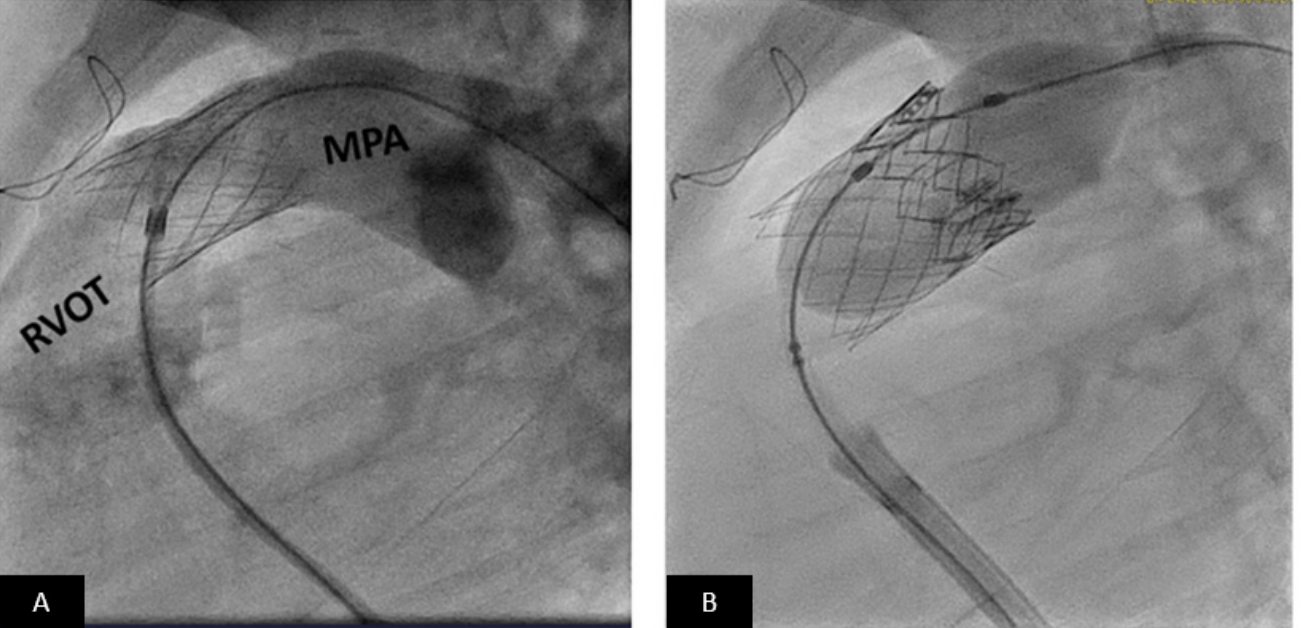
Figure 9. Transcatheter pulmonary valve replacement using an Edwards-Sapien XT valve. ( A ) Lateral angiogram showing a stented RVOT. ( B ) The angiogram shows Sapien valve (dark frame) deployment within the distal portion of the pre-stent. MPA = main pulmonary artery, RVOT = right ventricular outflow tract.